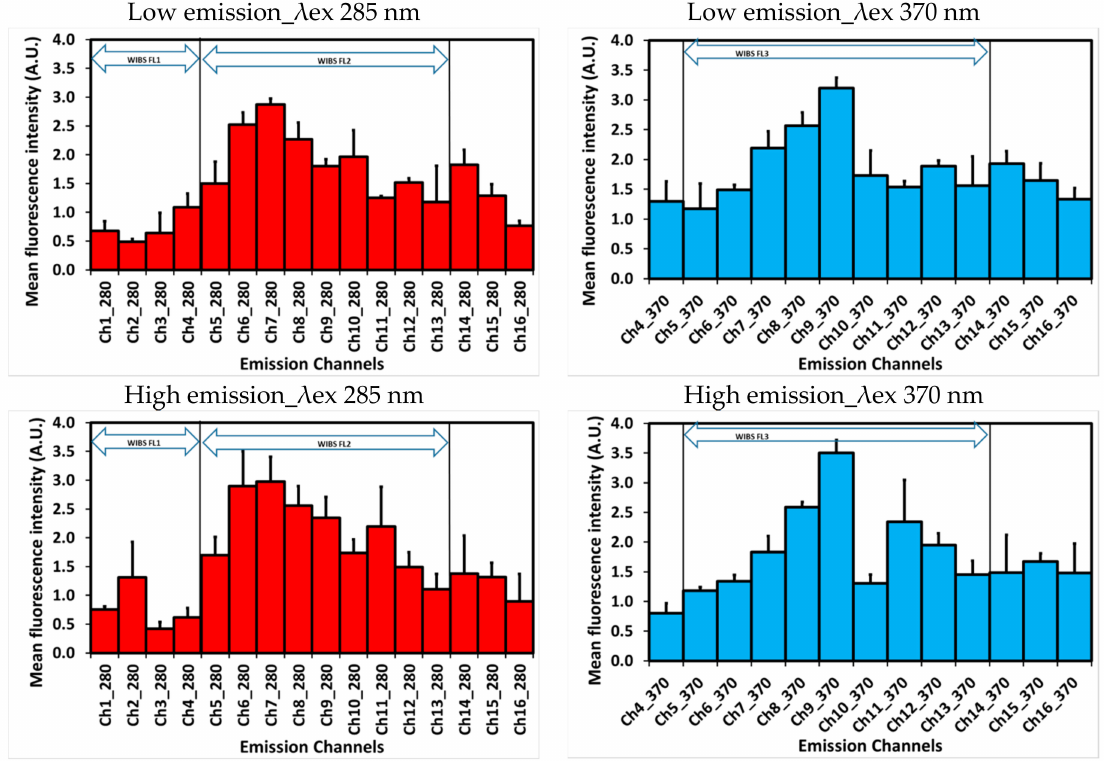
Figure 3. Representative fluorescence intensity across different emission channels for two excitation wavelengths during low and high emission scenarios. Bars = standard